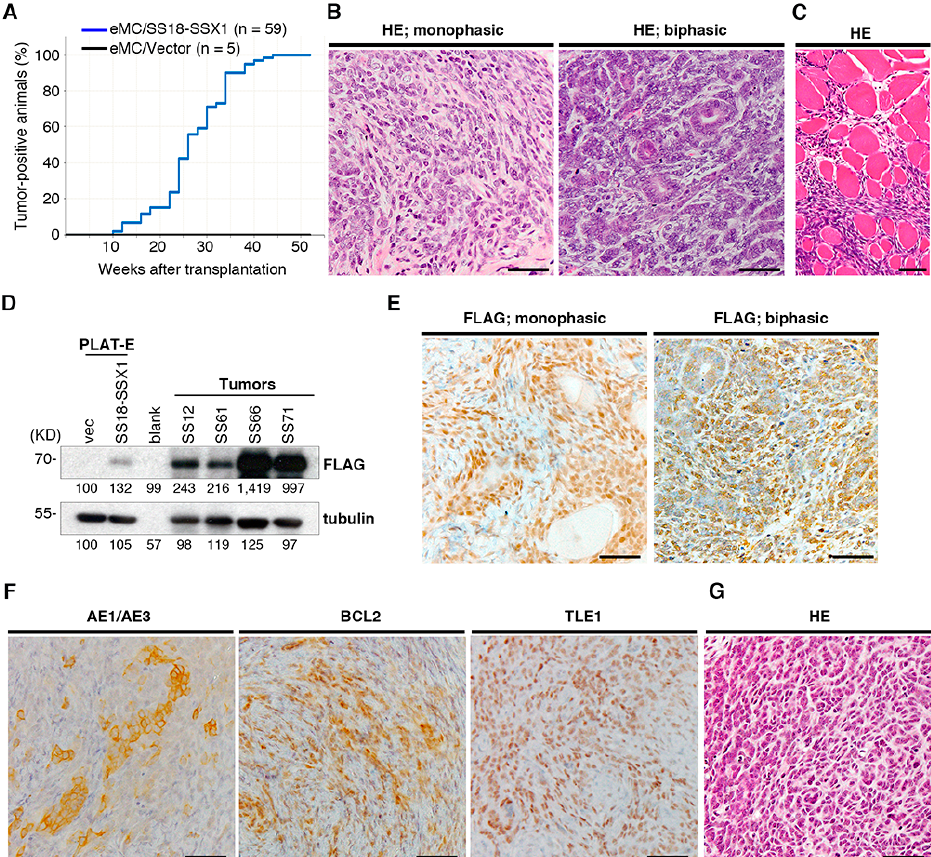
Figure 1. Generation of the mouse synovial sarcoma ex vivo model. ( A ) Cumulative incidences of synovial sarcoma. ( B ) Histology of mouse synovial sarcoma showing monophasic ( left ) and biphasic ( right ) patterns. ( C ) Infiltration of sarcoma cells into surrounding muscle tissue. ( D ) Immunoblotting of FLAG-SS18-SSX1 in tumor tissue. PLAT-E cells transduced with SS18-SSX1 or empty vector are used as positive and negative controls, respectively. ( E ) Accumulations of SS18-SSX1 in the nucleus of tumor cells are evident in both monophasic and biphasic tumors by immunostaining with anti-FLAG. ( F ) Immunostaining with anti-AE1/AE3, anti-BCL2, and anti-TLE1. ( G ) Histology of the secondary transplanted tumor. Scale bars indicate 50 μ m.